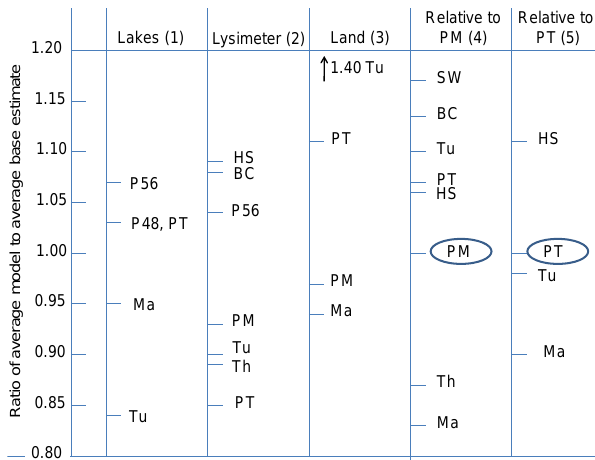
Fig. 4. Pictorial comparison of published evaporation estimates Figure 3 Pictorial comparison of published evaporation estimates* from Table 6. from Table 6. Values are average ratios of the nominated proce- dures to base evaporation. For the lakes, the base evaporation esti- * Values are average ratios of the nominated procedures to base evaporation. For the lakes, the base evaporation estimation was by water balance, eddy correlation or Bowen Ratio, and mation was by water balance, eddy correlation or Bowen ratio, and for lysimeter results the base was estimated for lysimeters containing grass. Land estimates for lysimeter results the base was estimated for lysimeters contain- were based on eddy correlation or Bowen Ratio. For the two columns to the right, the values ing grass. Land estimates were based on eddy correlation or Bowen were compared directly with Penman-Monteith or Priestley-Taylor, both set arbitrarily to a ratio. For the two columns to the right, the values were compared ratio of 1.00. Symbols are defined at the head of Table 6. directly with Penman–Monteith or Priestley–Taylor, both set arbi- trarily to a ratio of 1.00, which are denoted by the ellipse. Symbols are defined in the caption of Table